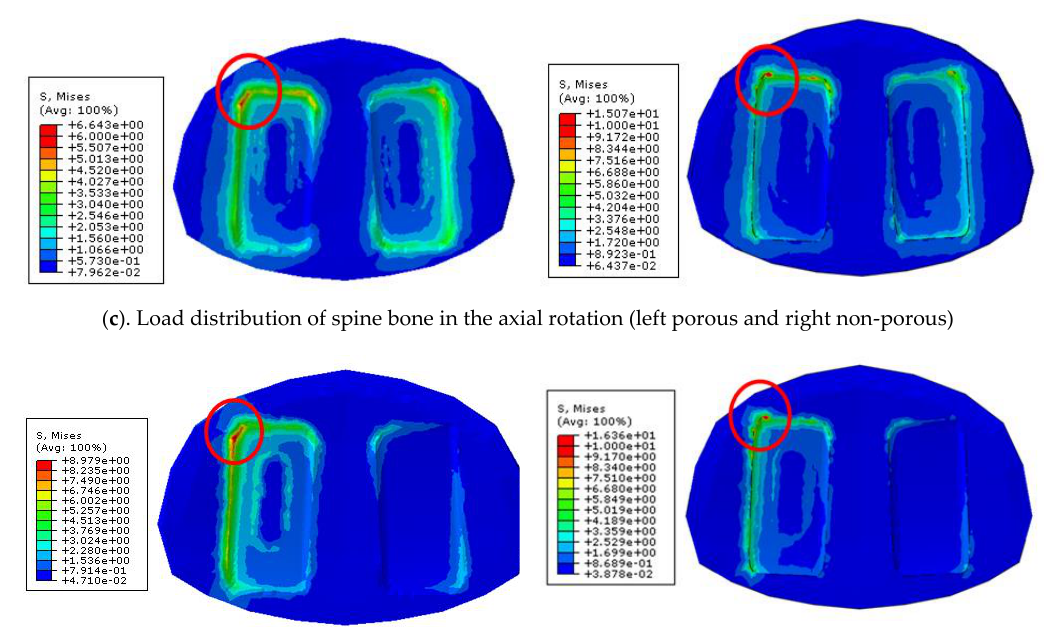
Figure 8. Load distribution of spine bone in the various motions